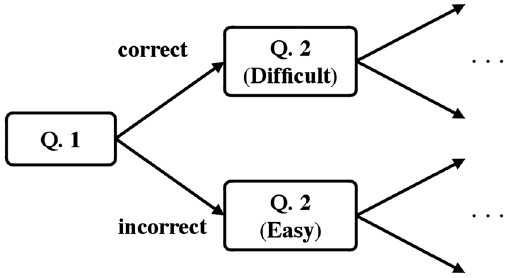
FIG. 1. Example of computerized adaptive testing. In this model of CAT, if a student answers an item correctly (incor- rectly), the student will next need to answer a more difficult (easier)